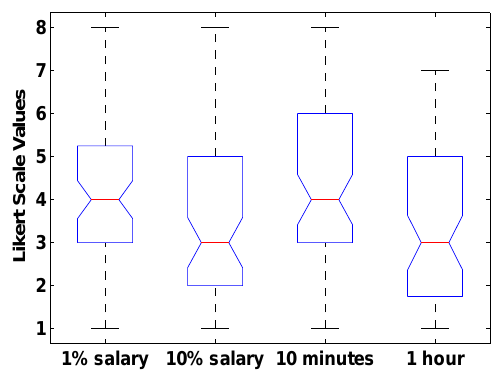
Figure 5. One way ANOVA of responses to User Benefits